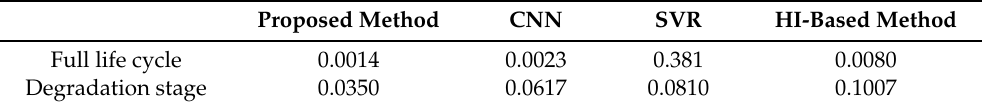
Table 3. MSE of the proposed method, CNN, SVR and the HI-based method in case 1. Proposed Method